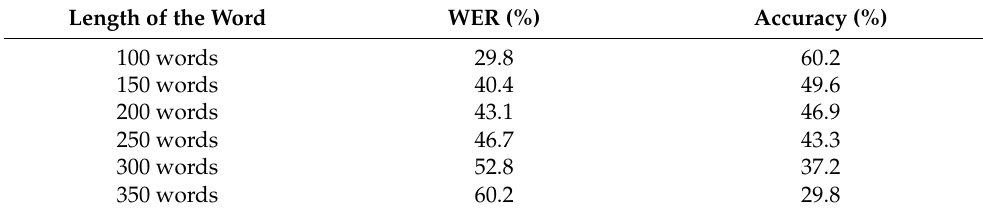
Table 3. WER and its percentage using subspace method.